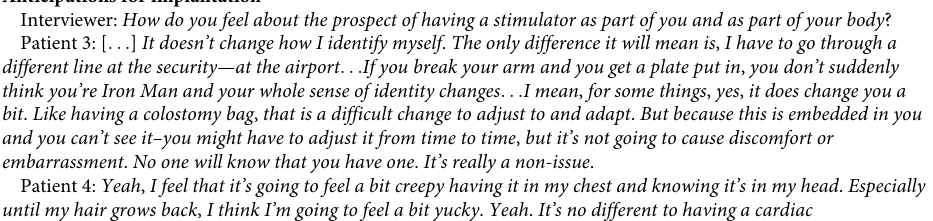
Table 3. Device acceptability and usability–Pre-DBS. Anticipations for implantation Interviewer: How do you feel about the prospect of having a stimulator as part of you and as part of your body ? Patient 3: [ ... ] It doesn’t change how I identify myself . The only difference it will mean is , I have to go through a different line at the security—at the airport ... If you break your arm and you get a plate put in , you don’t suddenly think you’re Iron Man and your whole sense of identity changes ... I mean , for some things , yes , it does change you a bit . Like having a colostomy bag , that is a difficult change to adjust to and adapt . But because this is embedded in you and you can’t see it–you might have to adjust it from time to time , but it’s not going to cause discomfort or embarrassment . No one will know that you have one . It’s really a non-issue . Patient 4: Yeah , I feel that it’s going to feel a bit creepy having it in my chest and knowing it’s in my head . Especially until my hair grows back , I think I’m going to feel a bit yucky . Yeah . It’s no different to having a